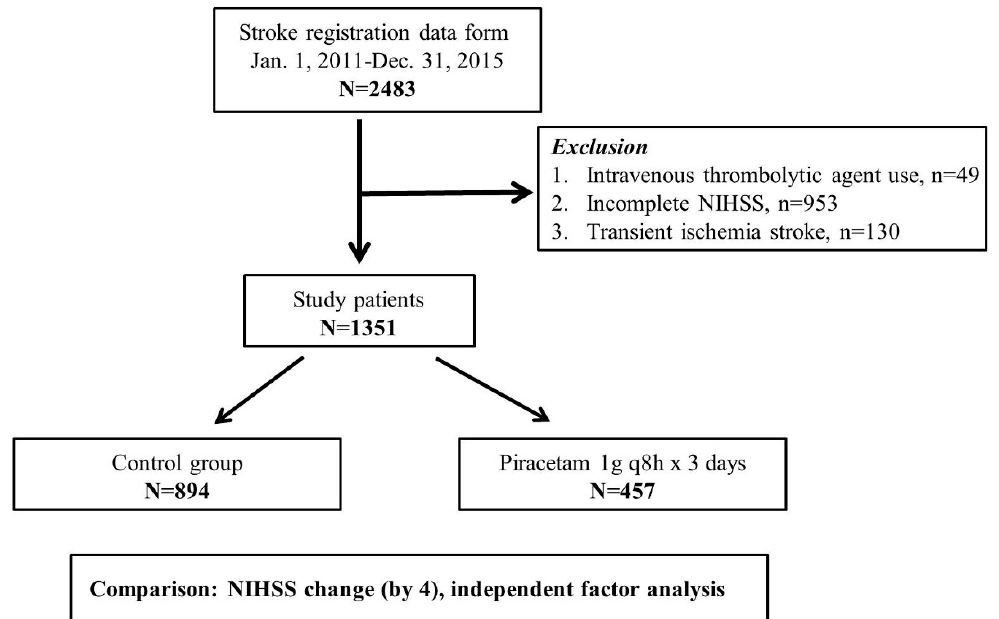
Figure 1. Flowchart of enrollment procedures for the study. A total of 2483 cases were registered during the study period and 1351 patients were recruited into piracetam treatment group and control group after the exclusion of those receiving intravenous thrombolytic agent within 3 h of symptoms onset ( n = 49), those having incomplete or erroneous admission or discharge NIHSS score ( n = 953) and those having transient ischemia stroke ( n = 130). NIHSS, National Institute of Health Stroke Scale. The NIHSS score was defined previously in [9]. Sample size was calculated based on the analysis for the association of piracetam treatment with NIHSS score change. The alpha error ( α ) was determined to be 0.05; the beta error ( β ), 0.2; power, 0.8 (1-beta error). The needed total